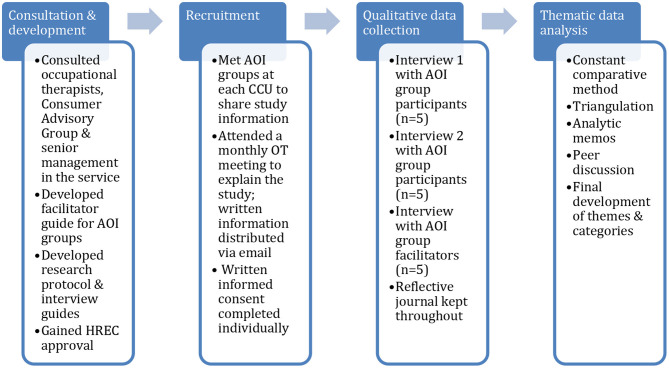
Research process.